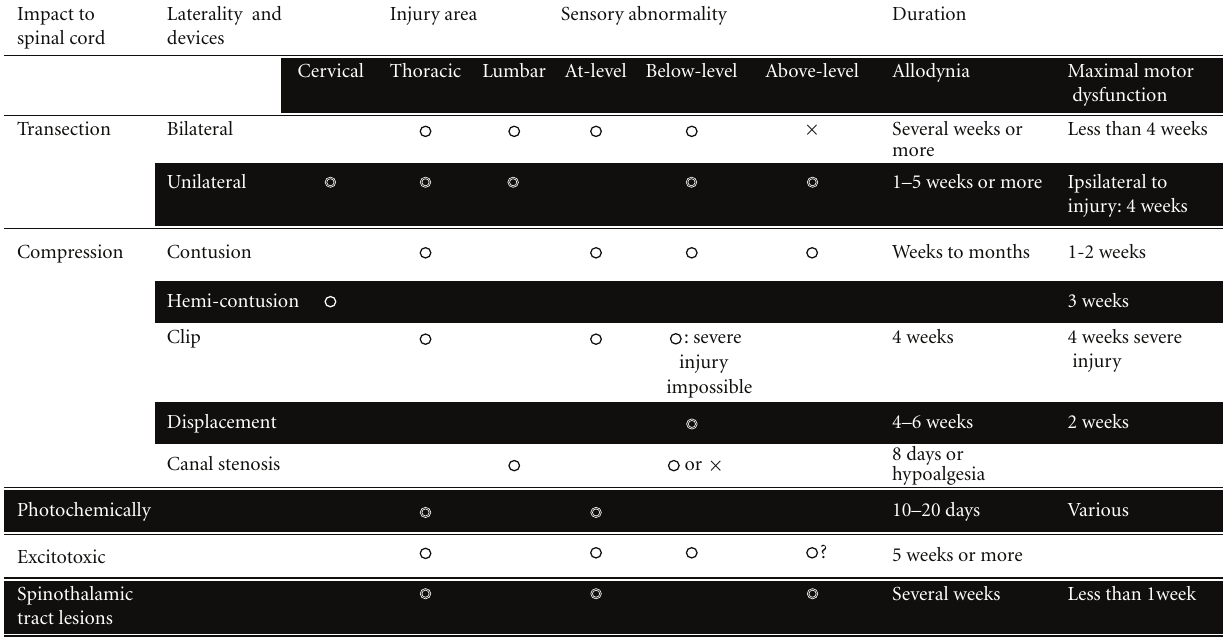
Table 3: Animal spinal cord injury models and